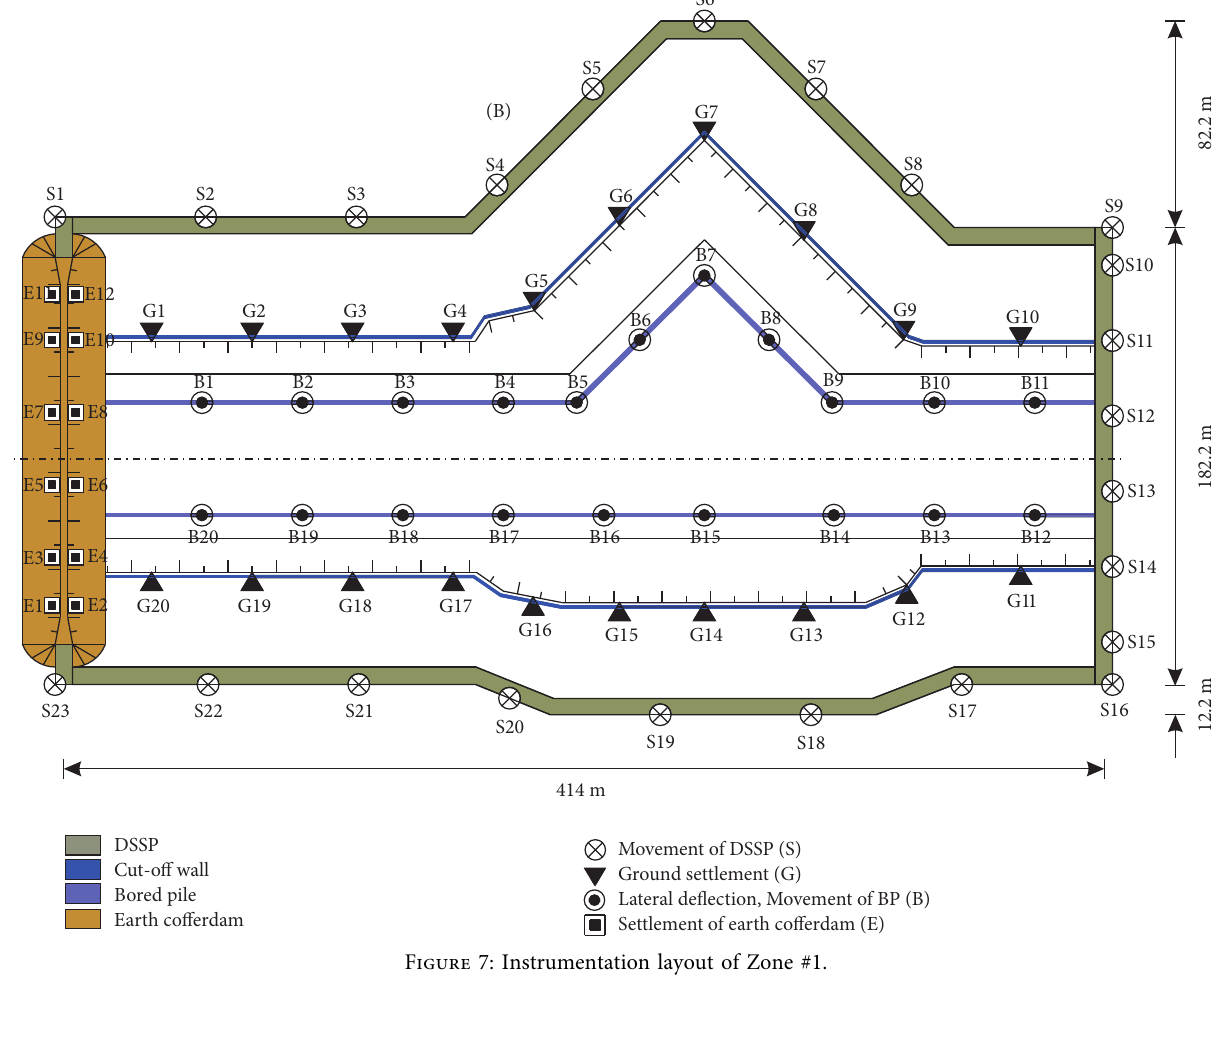
Figure 7: Instrumentation layout of Zone